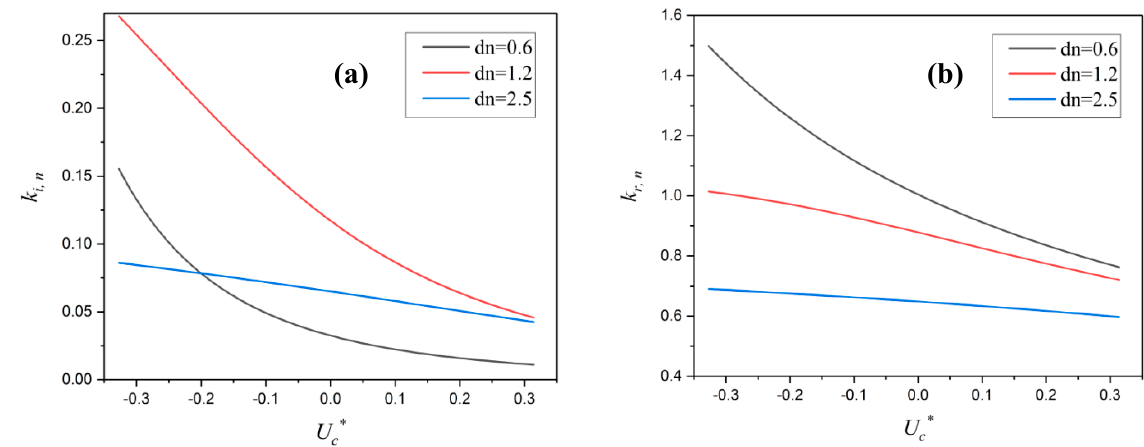
Figure 5. ( a ) Dissipation rate ( b ) wave number versus current velocity.